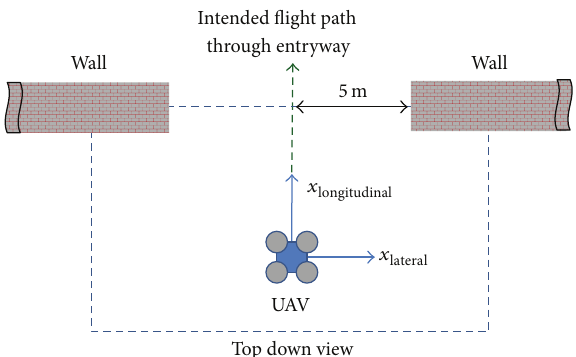
Figure 4: Depiction of the UAV flight control software test